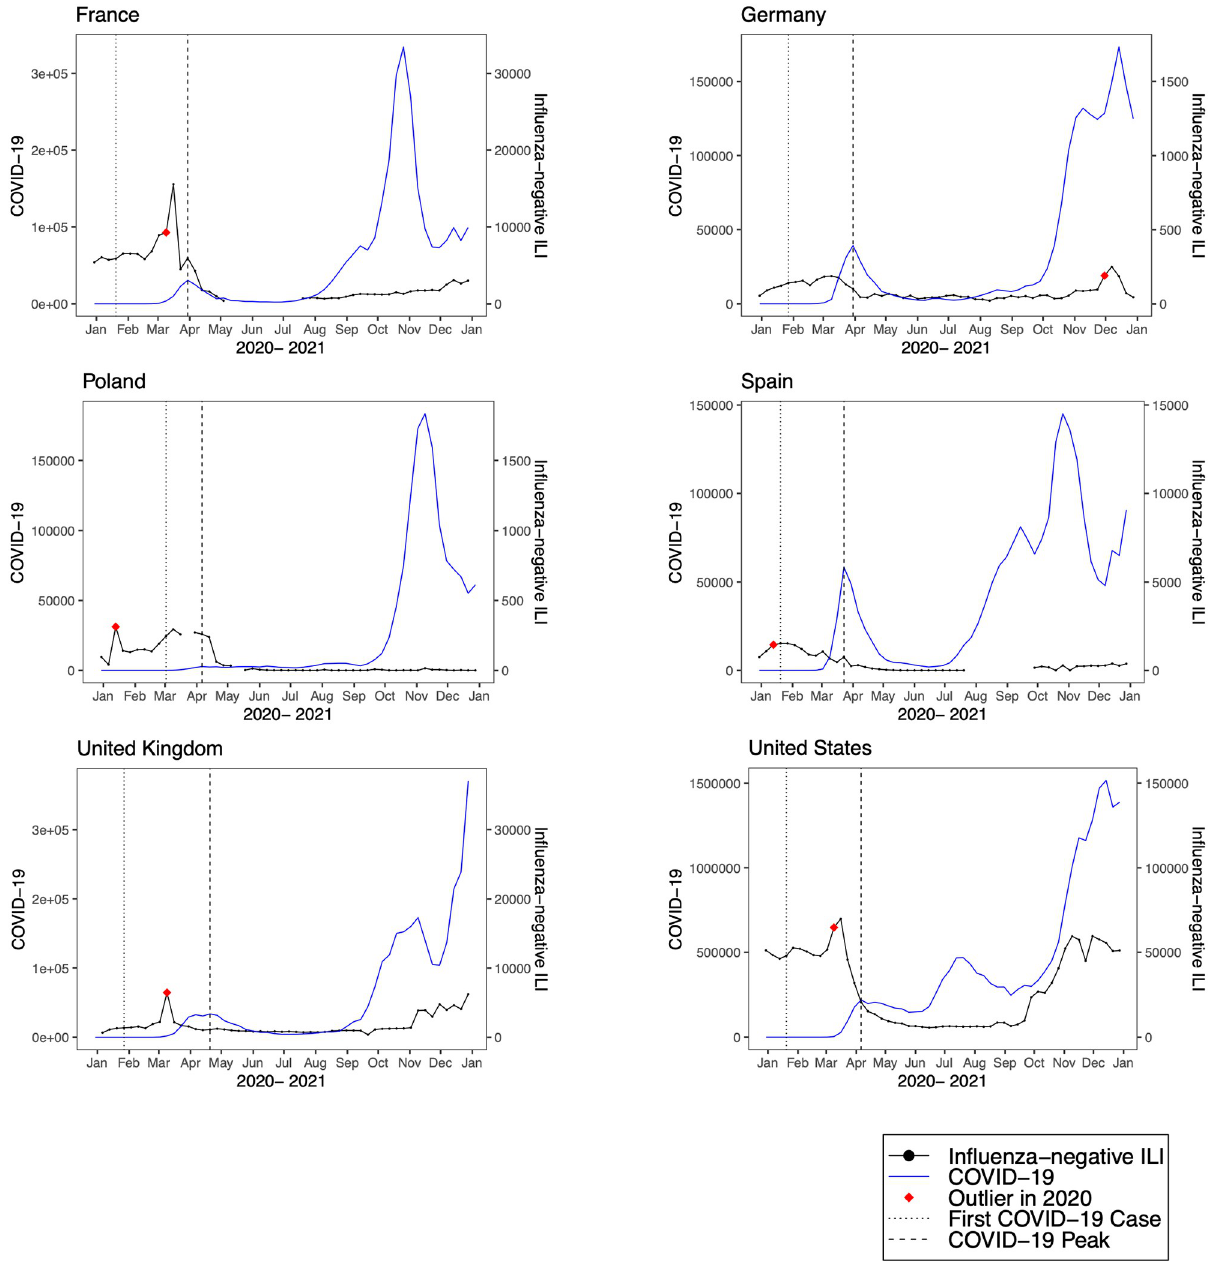
Fig 5. Observed trends in COVID-19 compared to influenza-negative influenza-like illness (ILI) in high-income countries. AU : PleasecheckthattheeditedlegendaddedtoFigs 5 (cid:0) 8 iscorrect : Trends in reported COVID-19 cases (blue line) and influenza-negative ILI cases (black line) during 2020. The vertical dotted black line indicates the week of the first COVID-19 case, the vertical dashed line indicates the week of the first COVID-19 peak, and the red diamond indicates the first detected influenza- negative ILI outlier in 2020.